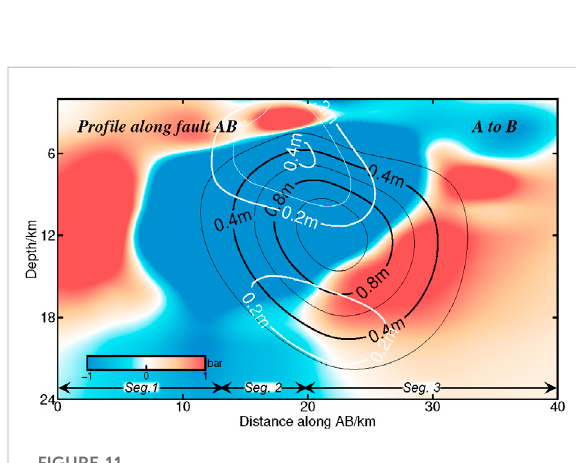
FIGURE 11 Coseismic Coulomb stress change at different depths along the faulting trace. The black and white lines indicate the coseismic and postseismic slip isoline projected on the surface, respectively. Caption is as for Figures 2,